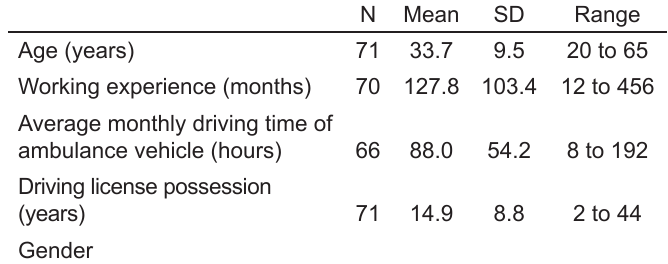
Table 1. Characteristics of the included drivers.